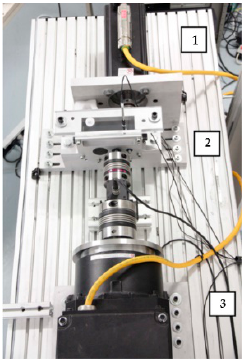
Figure 25. Illustration of the experimental setup, (1) Drive motor; (2) Lubrication gear; (3) Load motor (Reprinted with permission from Ref. [202]. Copyright 2012 Springer).